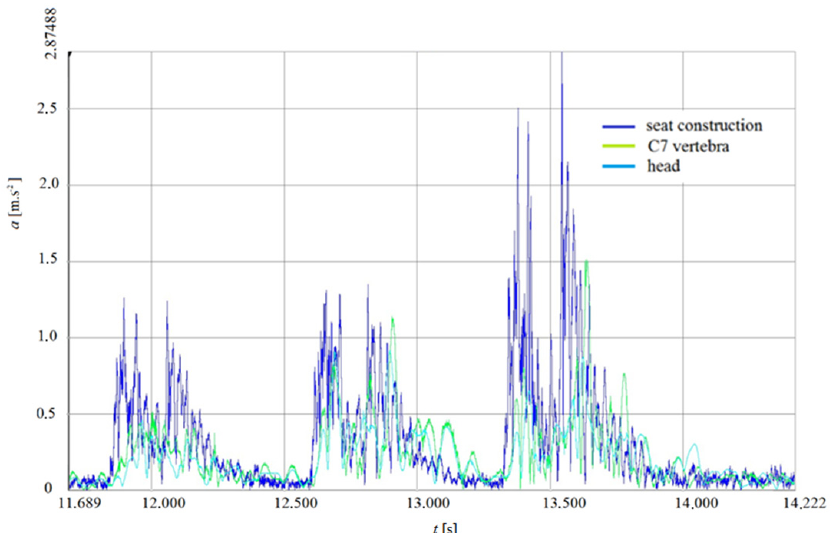
Figure 9. DRIVER (HUMAN)-dependence of acceleration in time of crossing obstacles—V5.